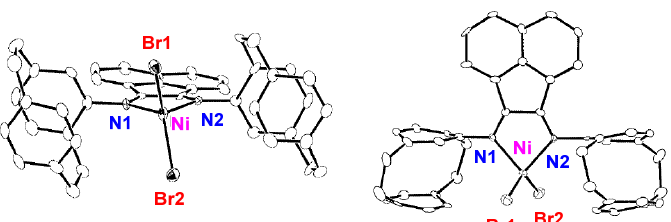
4 of 13 Figure 2. ( a,b ) Possible conformational isomers of L1 . ( c ) Temperature dependent 1 H NMR spectra of L1 at 25–120 °C. Ligand L1 reacts with NiBr 2 (dme) (dme = 1,2-dimethoxyethane) at room temperature to form the complex formulated as NiBr 2 ( L1 ), as shown in Equation (2). A direct reaction of NiBr 2 with 2,5-dimethylaniline and acetonaphtequinone produces Ni compex with a ligand having 2,5-dimethylphenyl substituents at the imine nitrogen, NiBr 2 ( L2 ), as shown in Equation (3). Ligand L2 also has 2,5-disubstituted aryl groups at the imine nitrogens, similar to L1 , but is sterically much less bulky than L1 . Catalytic activity of the complex is compared with that of NiBr 2 ( L1 ), having the sterically more crowded ligand.